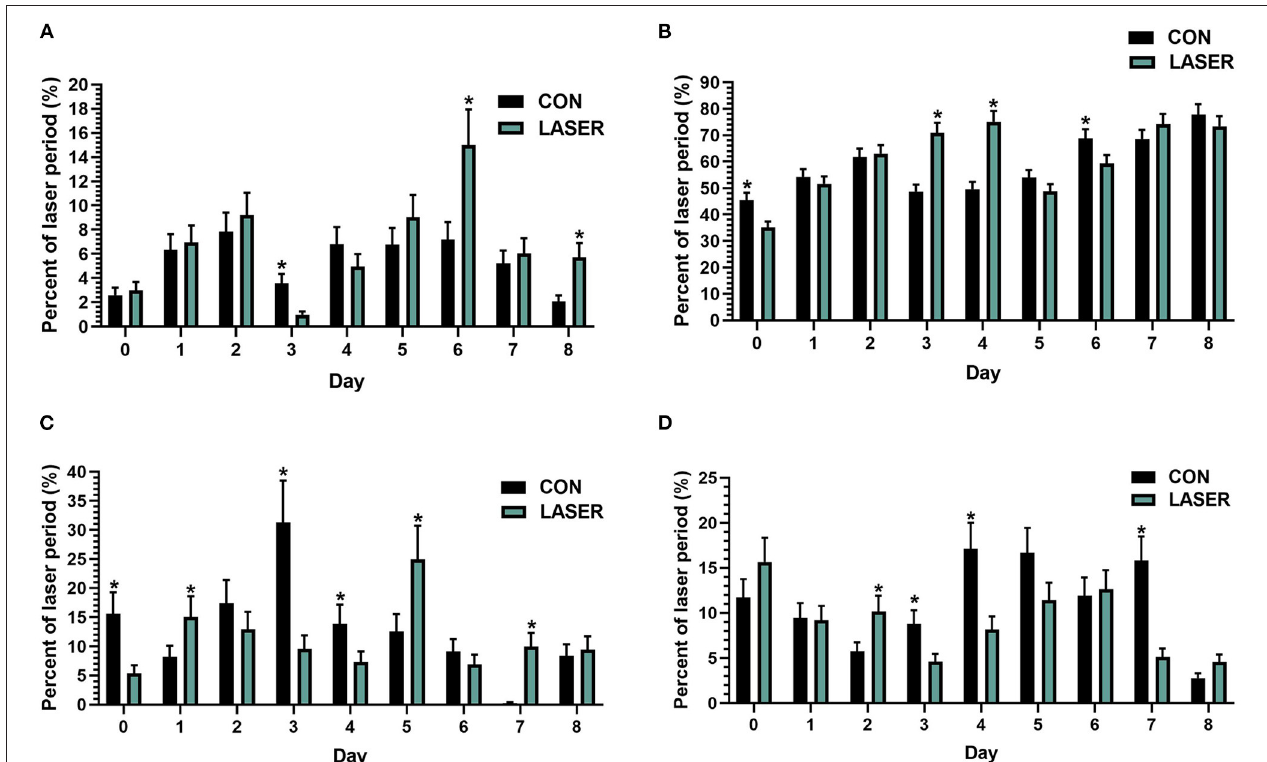
FIGURE 1 | (A–D) Ross 708 focal broiler home pen behavior over d0–8 during 4-min laser periods: enrichment × day LSMeans ( ± SEM) a . Percent of time spent: (A) active; (B) inactive; (C) at feeder; and (D) at drinker. a Bars denoted * indicate means that are significantly different within the same day/week ( P ≤